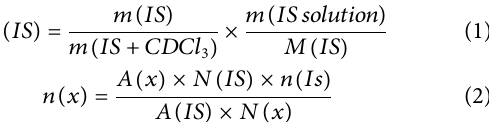
Frontiers in Chemistry |